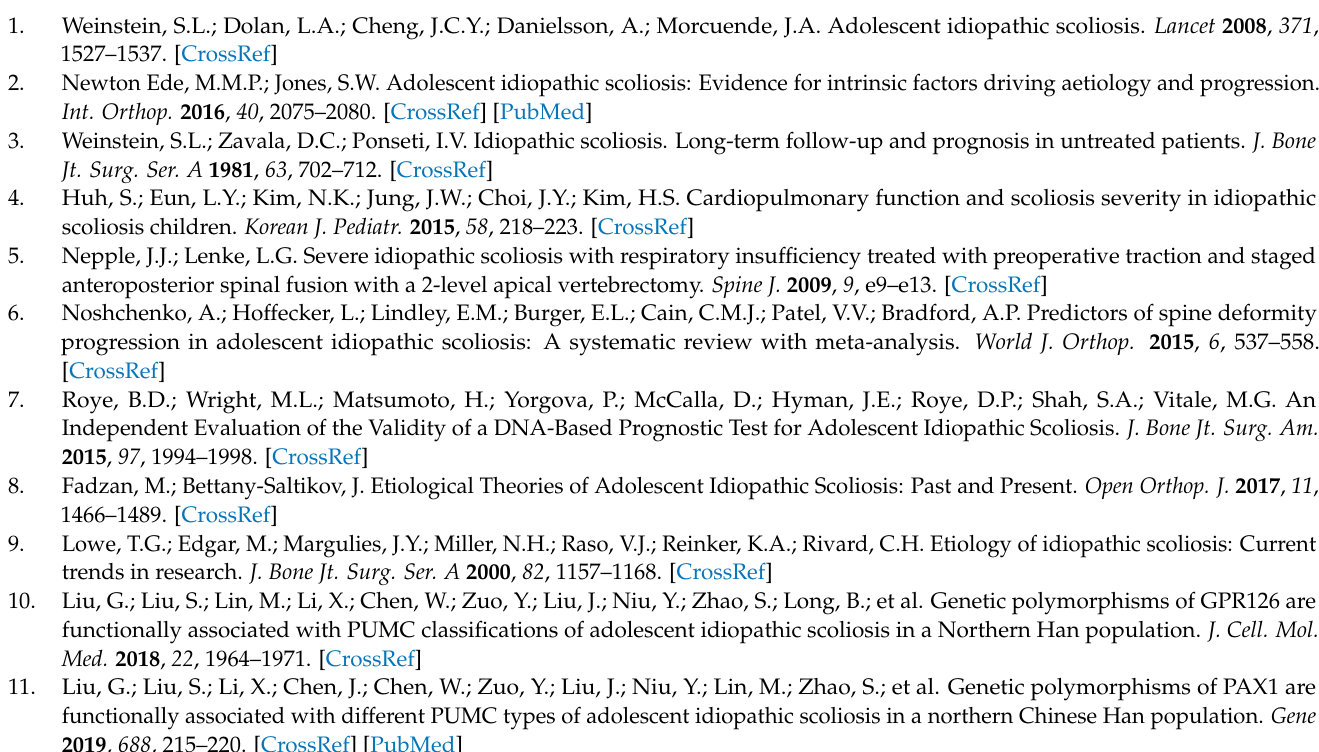
superficial muscles. Figure S3. Scatter plots showing correlations between ESR1 expression and methylation level within T-DMR2 region in deep paravertebral muscles and superficial